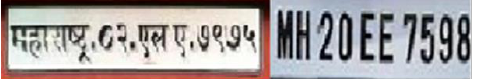
Fig. 6. Image of the cropped License Plate